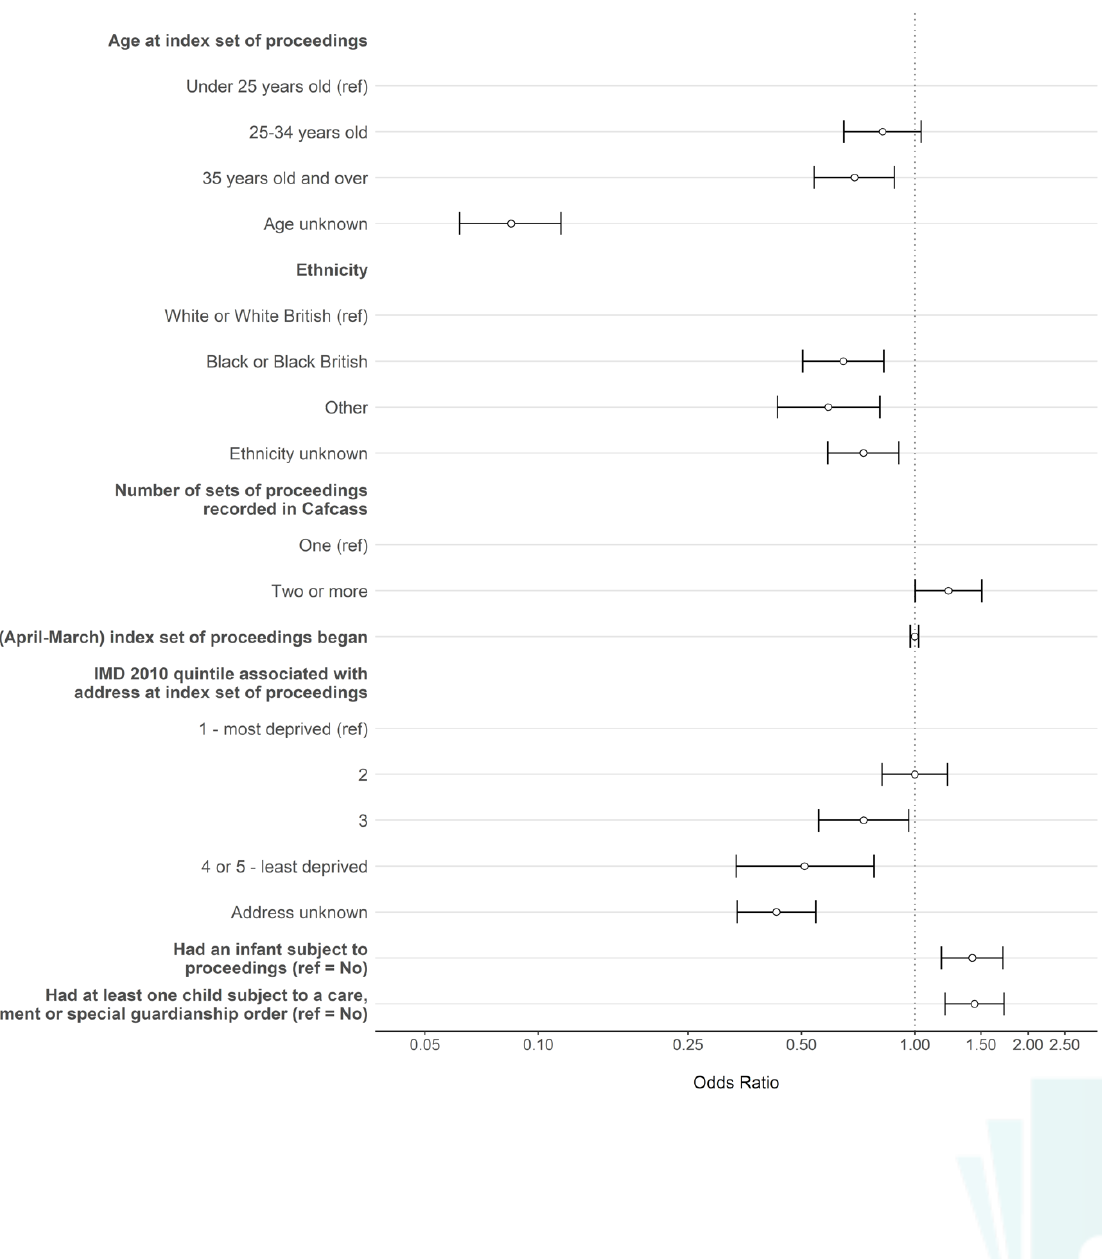
Figure 5: Modelling sociodemographic and case characteristics against match status among women involved in proceedings in Croydon, Lambeth, Lewisham and Southwark between April 2007 and March 2019: odds ratios with 95% confidence intervals (n =